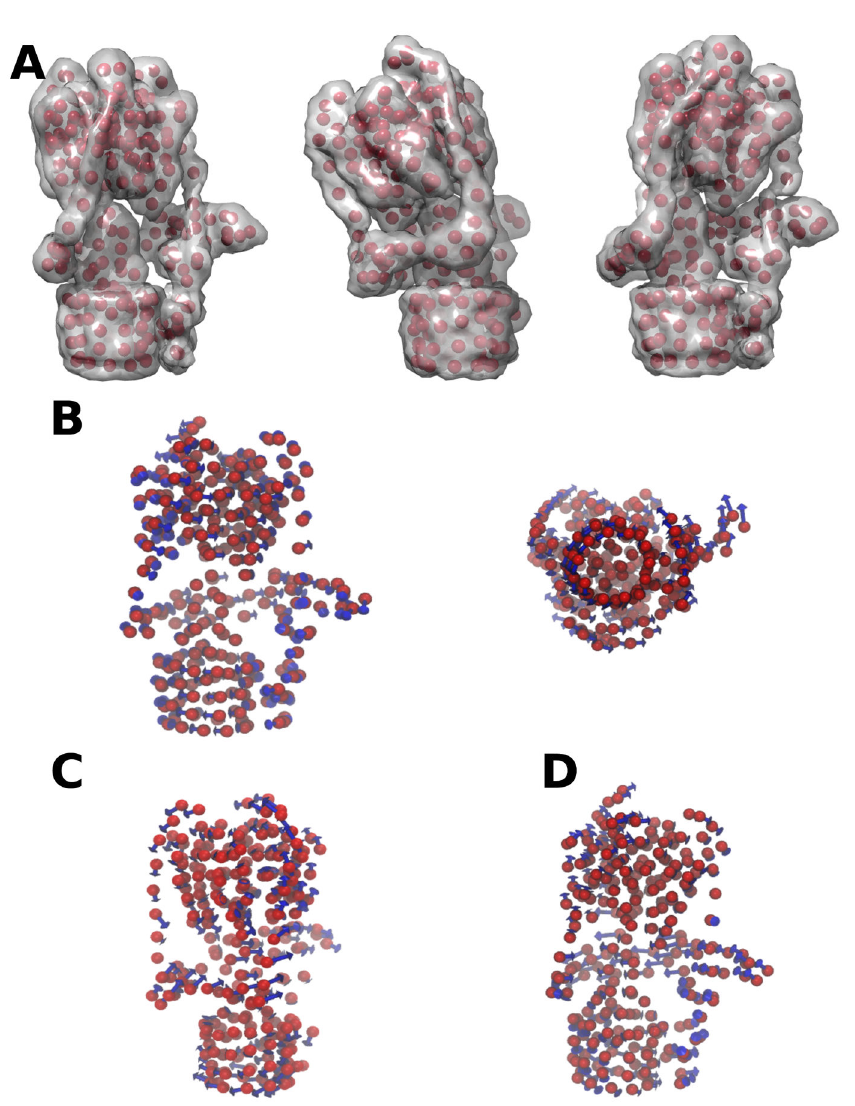
Figure 5. Deformation of the yeast V-ATPase along the first three non-trivial normal modes as calculated for the 256-bead ERNM. (A) Extreme conformers are depicted as a coarse-grained representation and as interpolated density maps, where the two motors are rotated against each other (left) or bended (middle, right). (B) Blue arrows represent the eigenvector corresponding to the first non-zero normal mode, which corresponds to twisting of the whole complex, consistent with the rotary mechanism of the V- ATPase. (C, D) The second and third modes of motion are bending motions with the soluble motor flexing (V ) with respect to the 1 membrane rotor domain (V ) either back-forth (C) or side-by-side (D) suggesting that V-ATPase is laterally compliant. o doi: 10.1371/journal.pone.0082207.g005 is proposed to mediate elastic power transmission between the asymmetric ATPase and H + translocation motors in F-ATPase. Single molecule experiments indicate low compliance for the single peripheral stator filament in F-ATPase (i.e. low flexibility), but a highly compliant γ-subunit axle that most likely fulfils the power transmission role [57,58]. Corresponding observations have not been made with the V-ATPase, but the existence of a similar elastic function is implied by the need to satisfy the motor asymmetry also present between V and V . 1 o